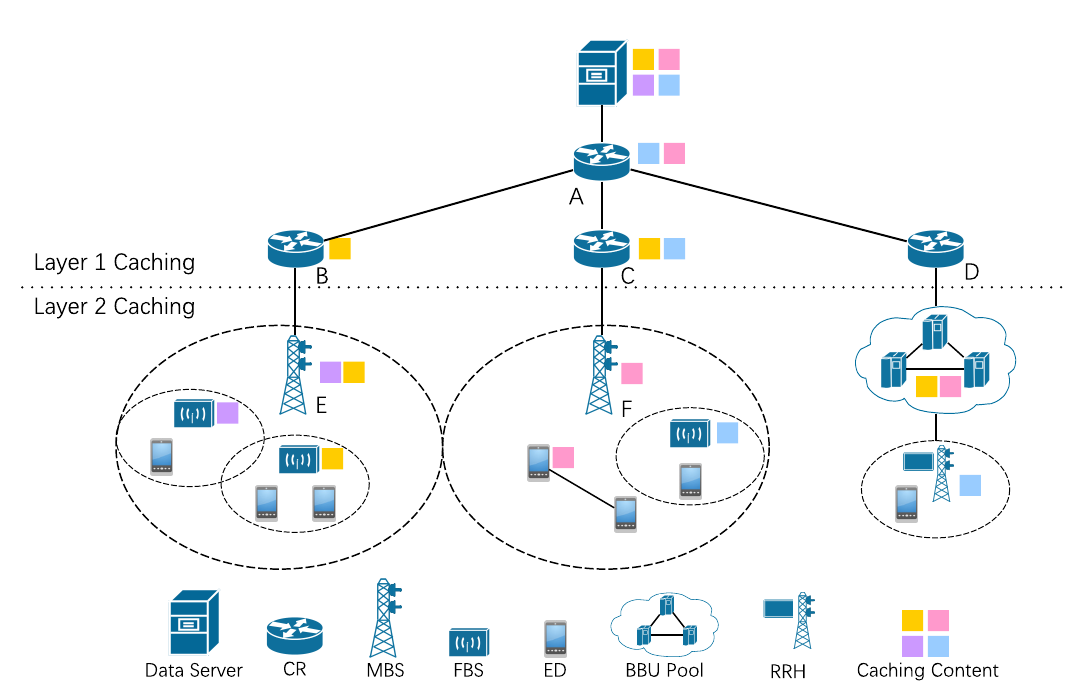
Figure 2. Data caching in edge